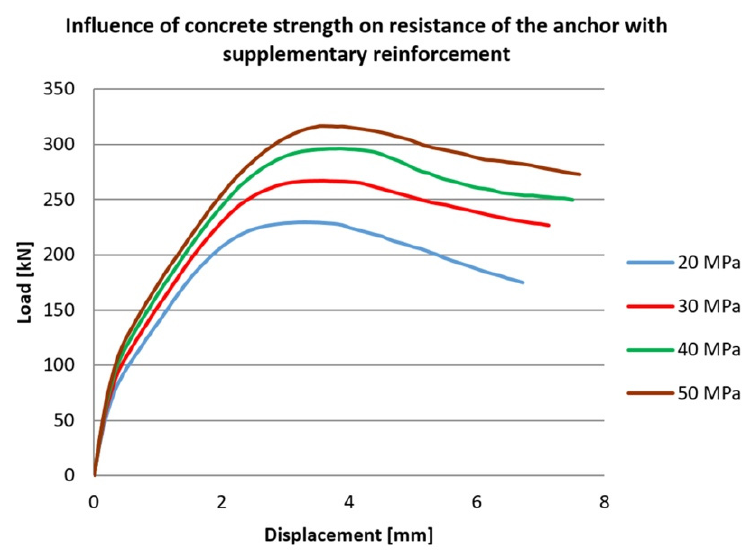
Figure 20. Influence of concrete compressive strength on the resistance of the anchor with supple- mentary reinforcement.